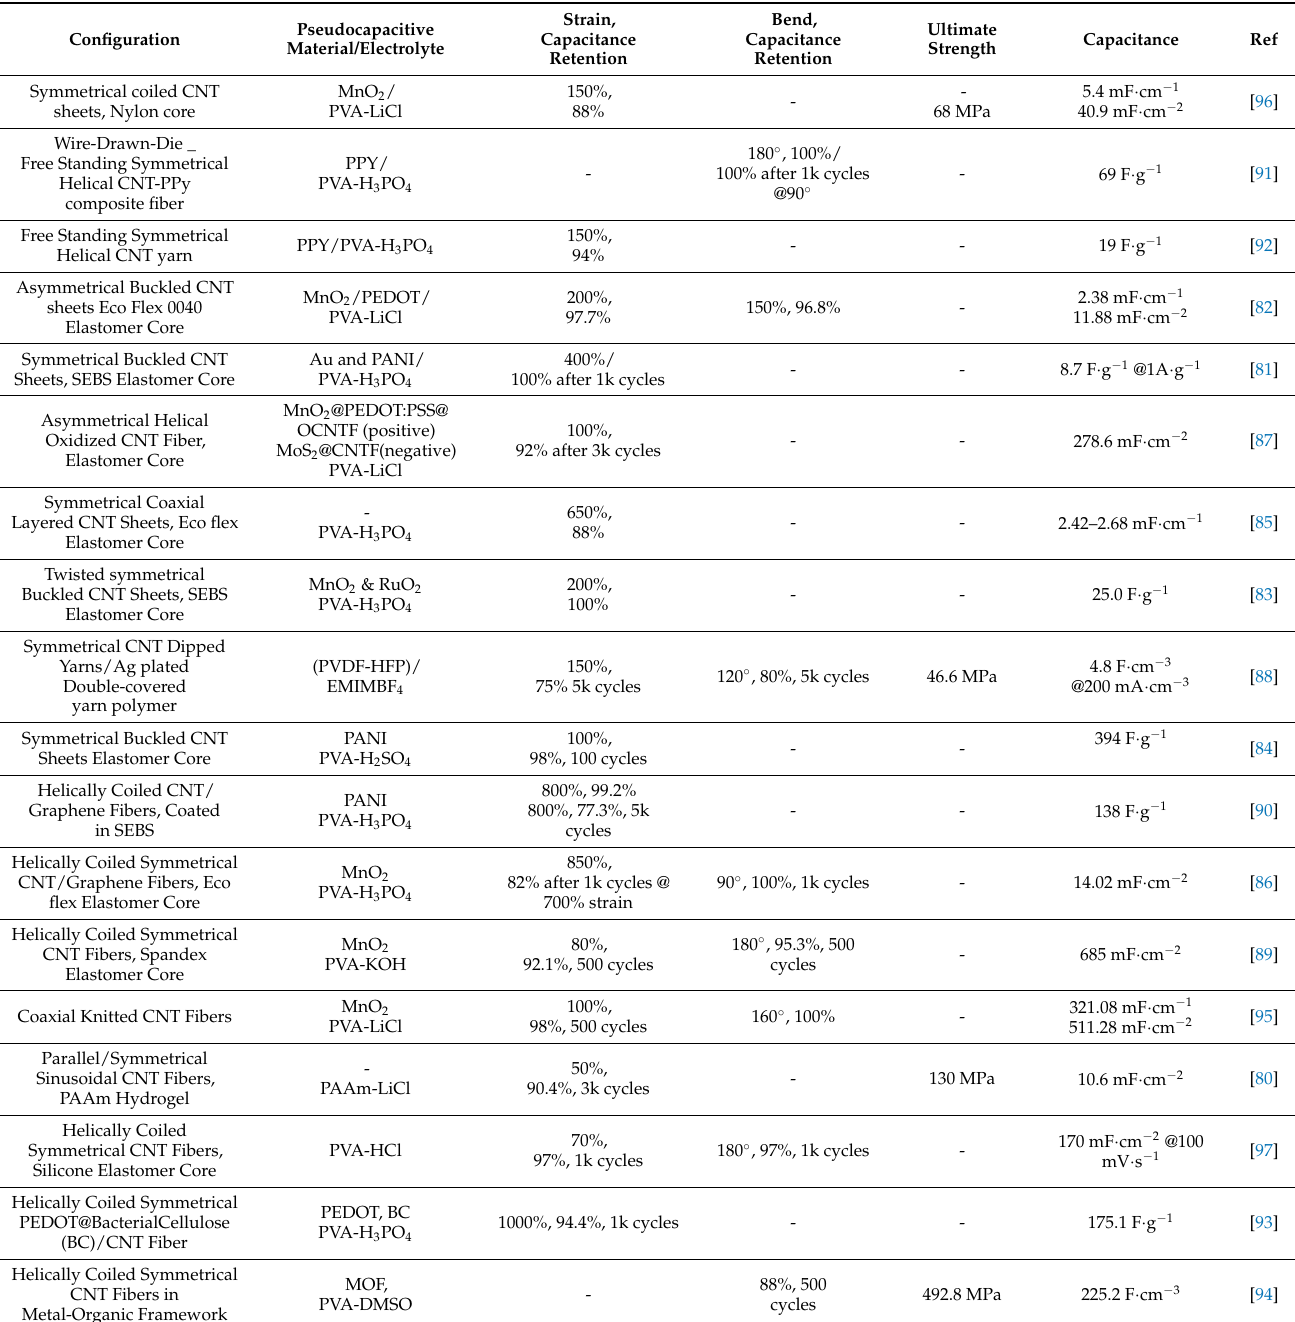
Table 5. Summary of the stretchable supercapacitors and their characteristics, as recently reported in the